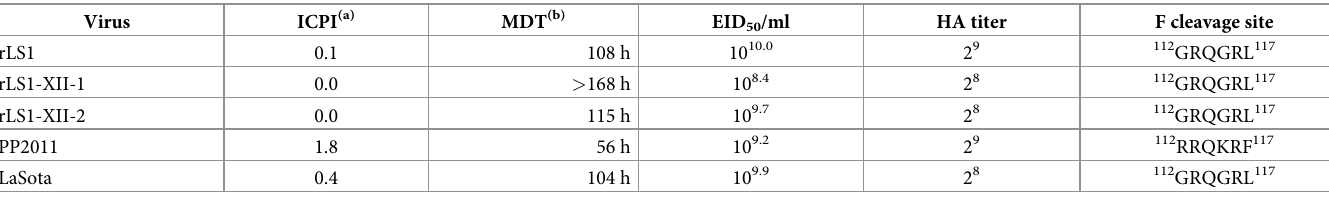
Table 2. Biological characteristics of NDV strains used in this study.